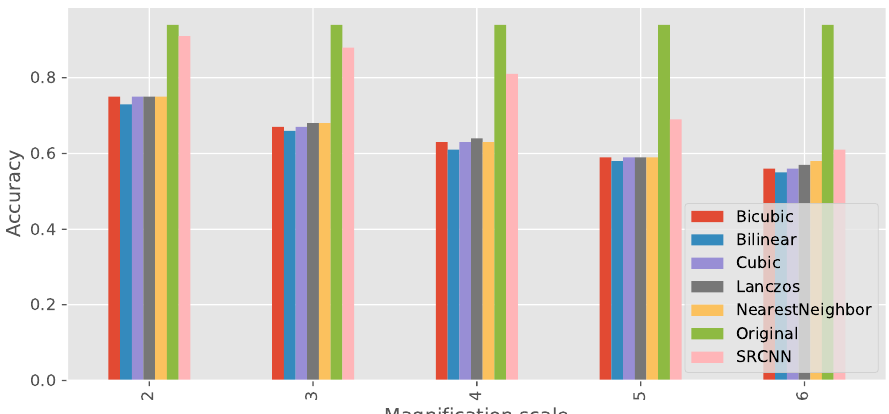
Figure 4. Accuracy of disease classification using high-resolution, low-resolution, and super-resolution images at different magnification scales.